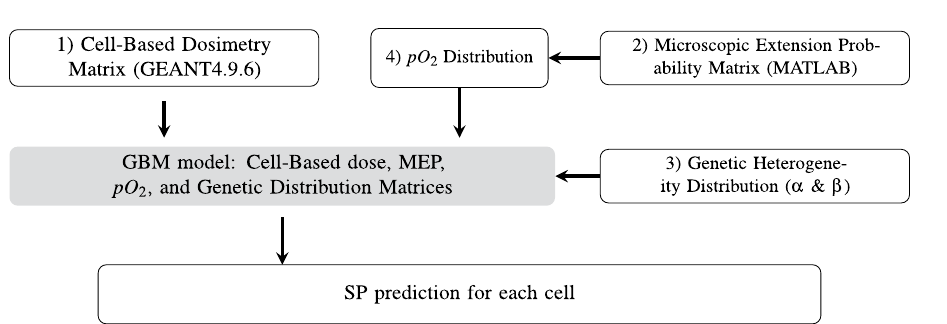
Figure 1. diagrammatic representation of the structure of the model components developed in the previous work 34